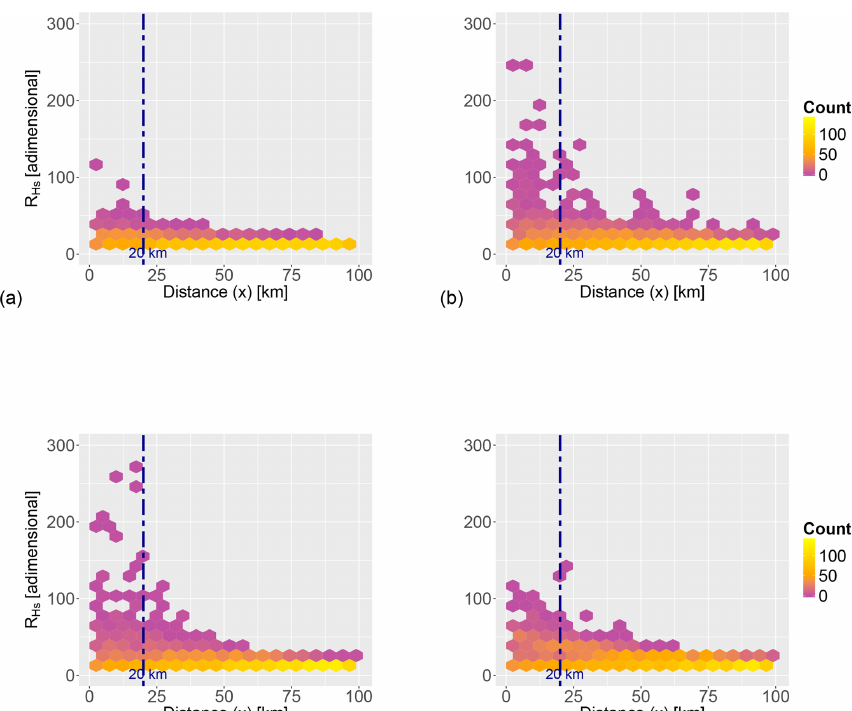
Figure 7. Heat map of the geostatistical anisotropy ratio of significant wave height ( R H ) against distance to the coast for (a) south control s transect (near the Ebro Delta), (b) central-south transect (near Tarragona harbour), (c) central-north transect (near Mataró harbour) and (d) north control transect (near Begur cape). The elements selected to aggregate samples for the heat map are hexagons with 5km side and a scale for anisotropy of 20 units. The counts are the number of elements within a hexagon. A rough limit of the order of magnitude for the direct applicability of remote-sensing data (20km) is also shown (dashed blue line). All plots correspond to February